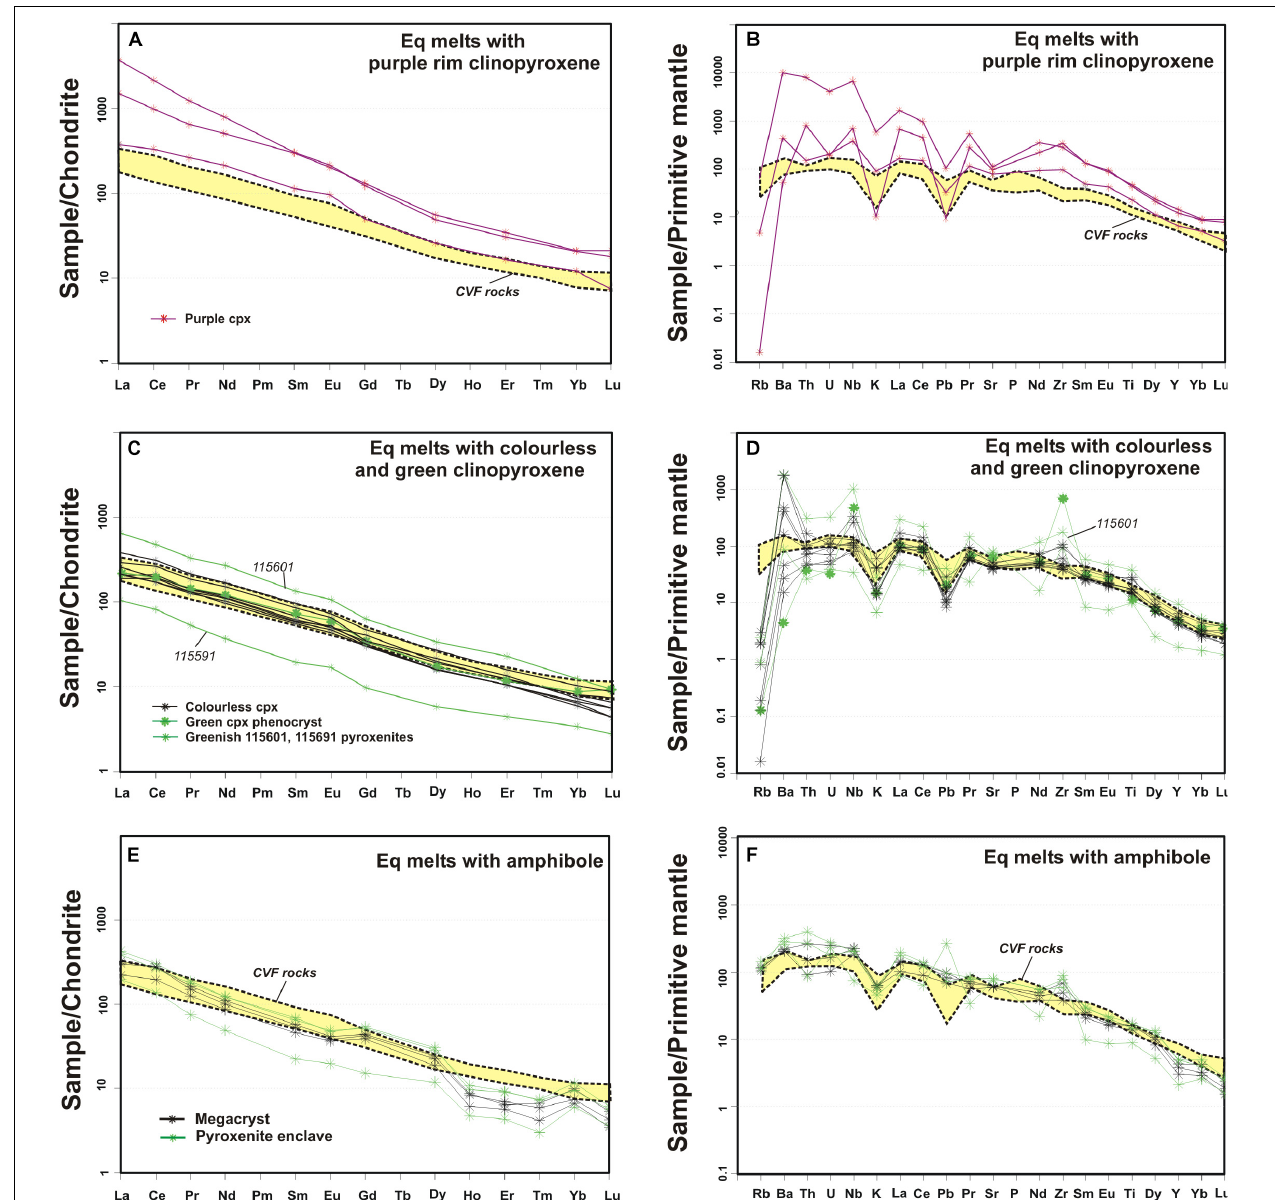
FIGURE 12 | Chondrite- and primitive mantle- normalized patterns of calculated melt compositions in equilibrium with clinopyroxene (A–D) and amphibole (E,F) , compared to the Calatrava Volcanic Field (CVF) compositional field. Chondrite and primitive mantle values are from Boynton (1985) and Sun and McDonough (1989),